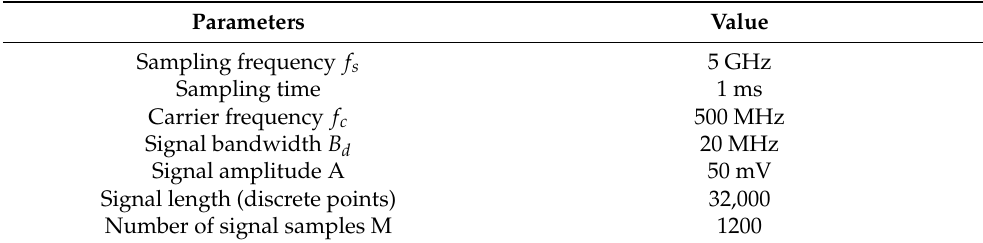
Table 4. Various parameters of the real measured